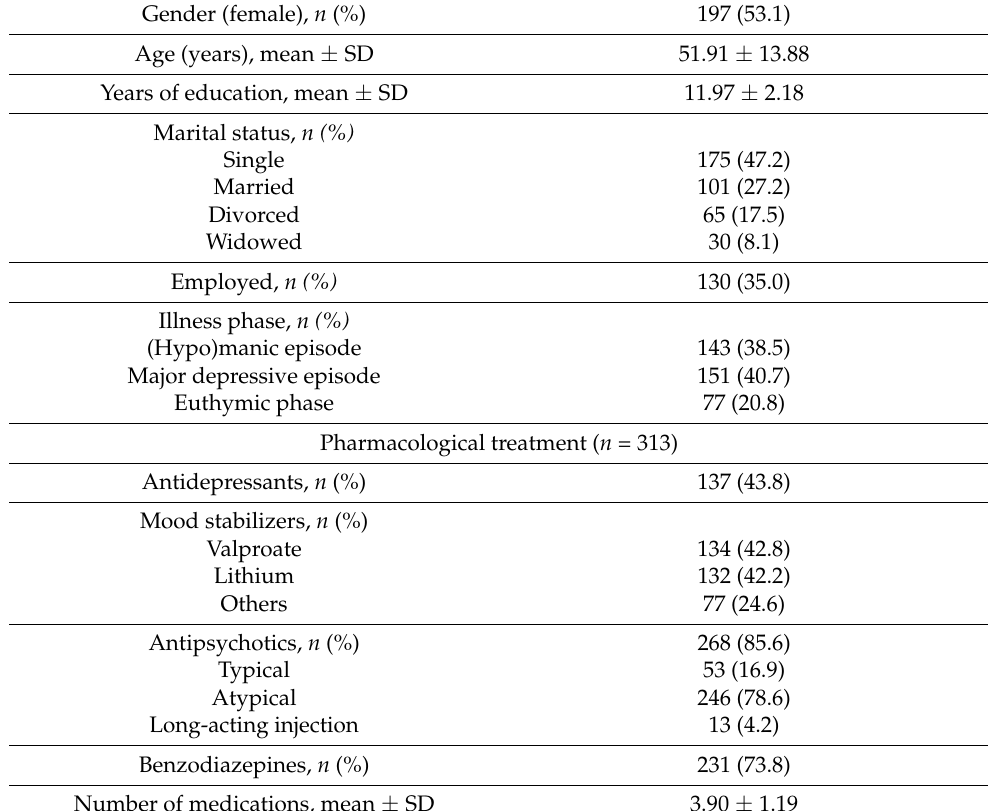
Table 1. Characteristics of the total sample ( n =